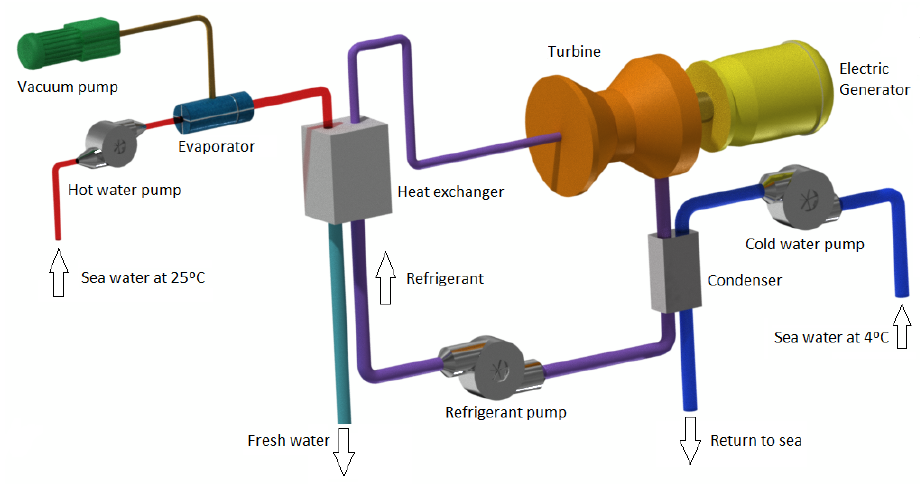
Figure 4. Hybrid cycle OTEC